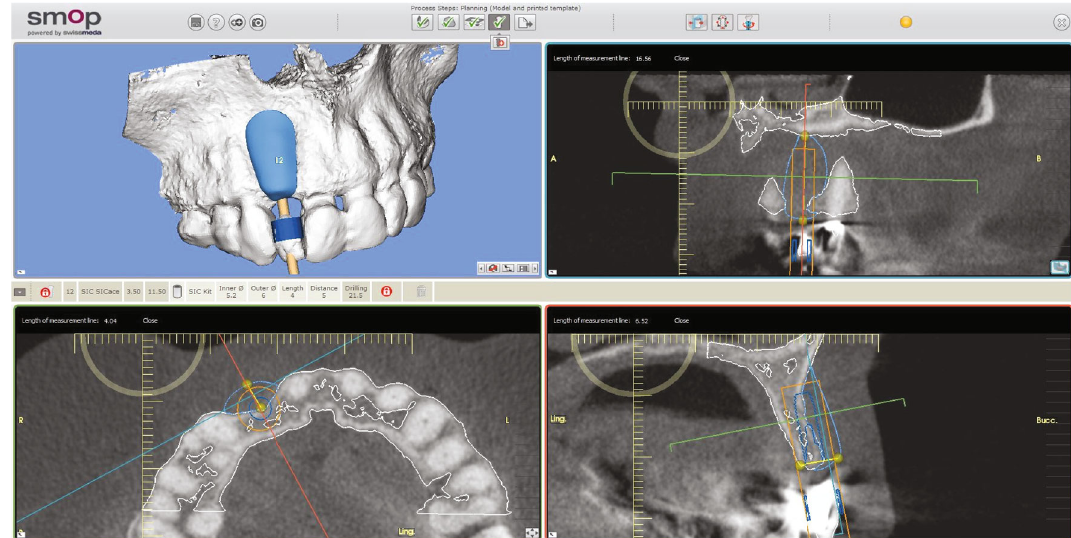
Figure 7: A planning tool for implant positioning and producing a SMOP template (Smop, Swissmeda, Baar, Switzerland) for navigated implant placement. Multiplanar view with 3D BB superimposed on the implant position.